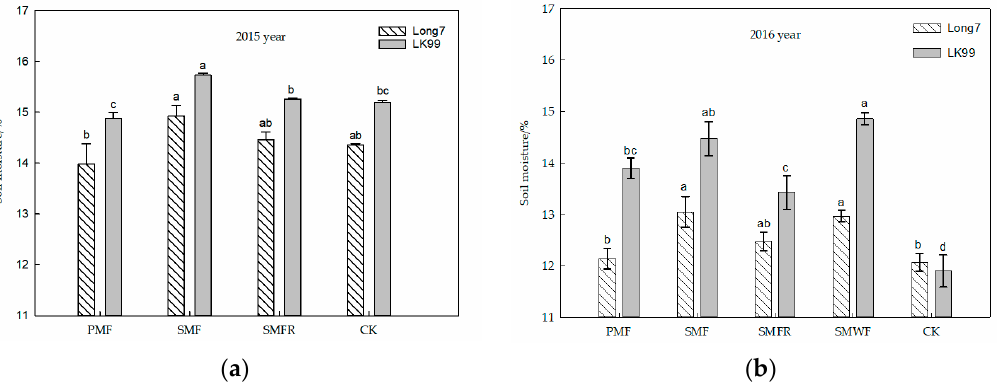
Figure 5. ( a , b ) Mean soil moisture in 0–200 cm during whole growth period under different treatments in ( a ) 2015 and ( b ) 2016. Data are means of three replicates. Different lower case letters in the same columnar section are significant differences at 0.05 level. Error bars are the standard deviation of means ( n = 3).